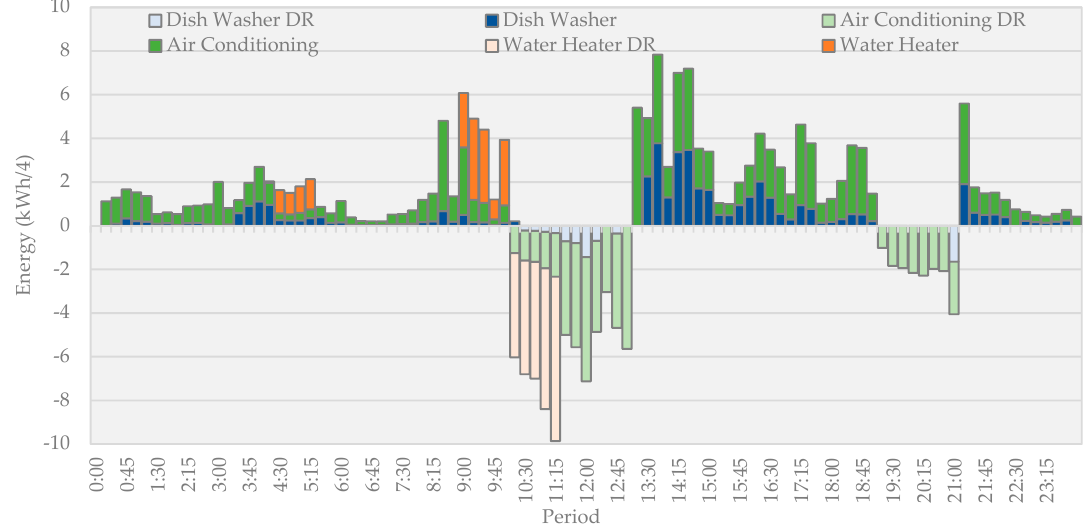
Figure 4. DR result regarding initial profile.